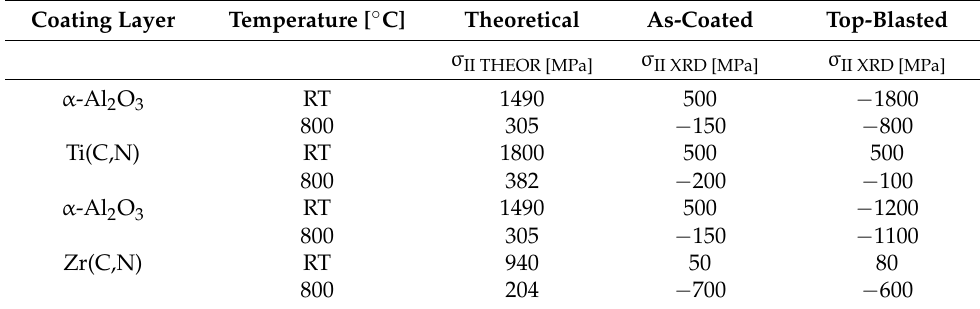
Table 3. Theoretical vs. averaged estimated residual and thermal stresses for the systems investigated at RT and 800 °C.